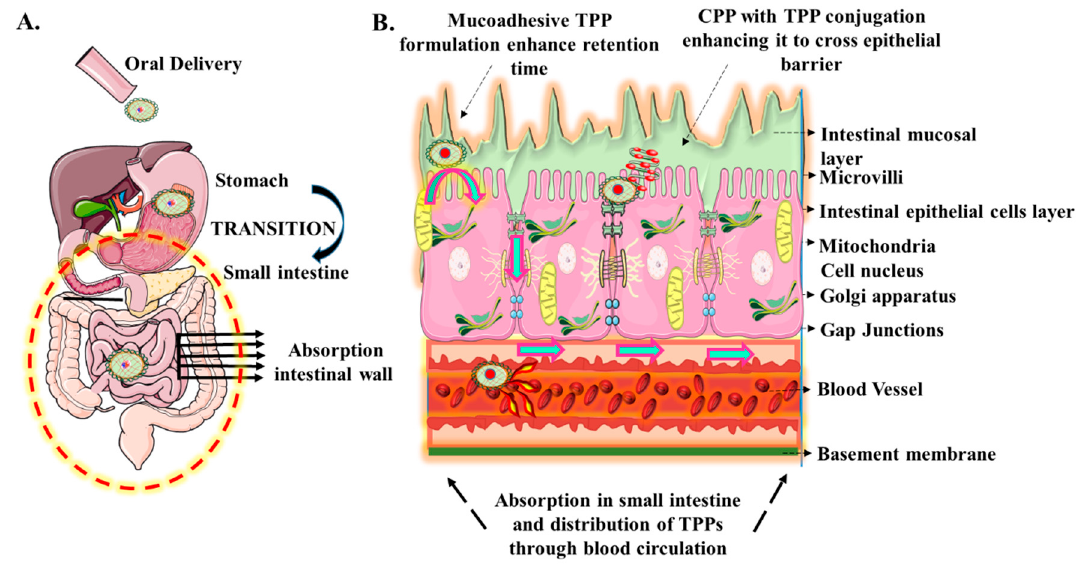
Figure 2. Oral delivery of drugs and their absorption into the bloodstream. ( A ): Path of orally administered therapeutic peptide and proteins (TPP) through the digestive system; ( B ): key components and pathways for absorption through the intestinal epithelial barrier.